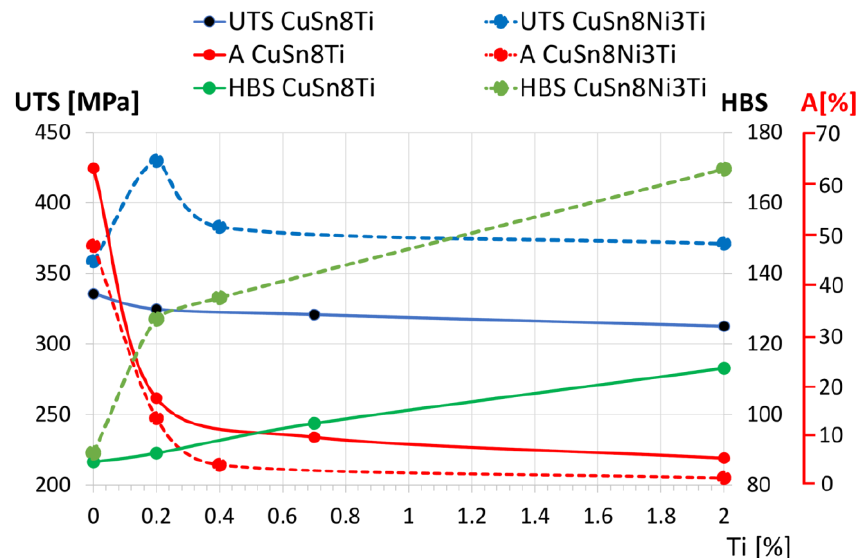
Figure 10. Graphical representation of the mechanical properties of samples made of CuSn8+Ti and CuSn8Ni3+Ti alloys. Table 8. Mechanical properties of selected alloys from the Cu-Sn-Ni-Ti group.